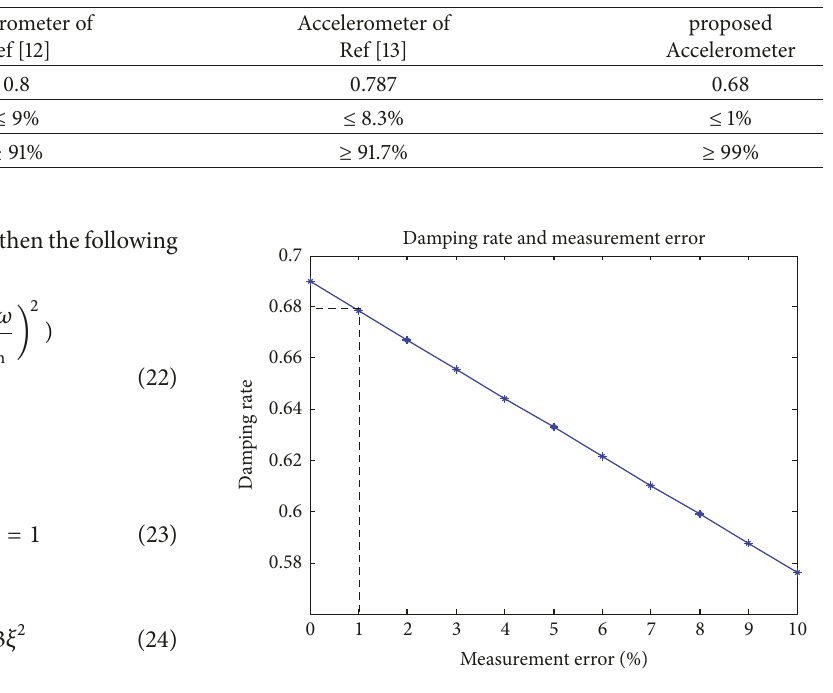
Figure 12: Damping rate as a function of measurement